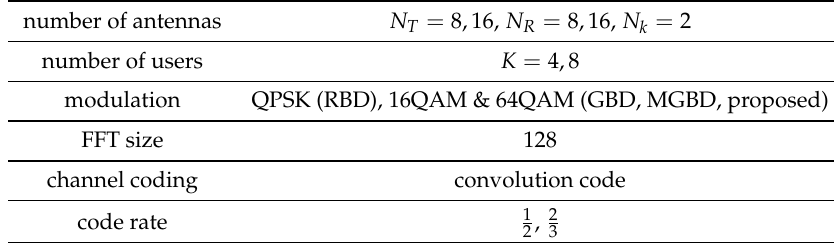
Table 5. Simulation parameters.